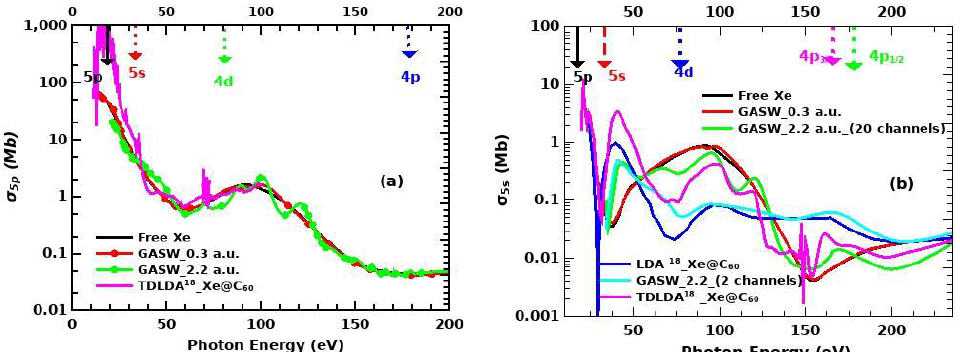
Figure 12. Comparison of photoionization cross-sections of ( a ) 5p ( left panel ) and ( b ) 5s ( right panel ) orbitals of free and confined Xe using the RRPA with LDA [18] and TDLDA [18] results. Vertical arrows indicate the threshold values of the corresponding subshells used in the